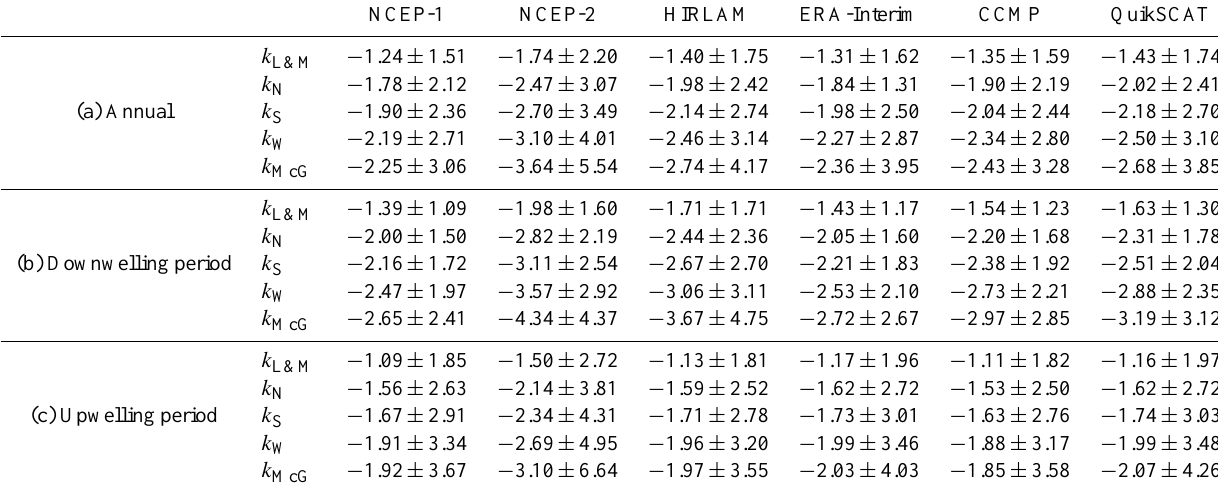
Table 2. Mean (and standard deviation) of the F CO 2 flux (mmolm − 2 day − 1 ) computed along the ECO route using various wind products and gas transfer velocity parameterizations, during the complete study period (a), during the downwelling season, defined here from October to February (b) and the upwelling season, defined from April to August